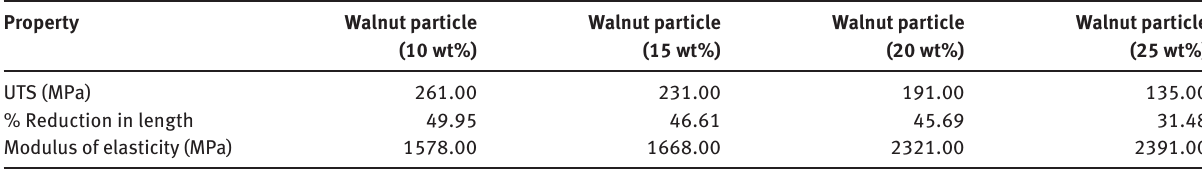
Figure 3 Variation of ultimate tensile strength, modulus of elasticity and elogation for different weight percentage of walnut reinforced composite. Table 4 Compressive properties of the composite